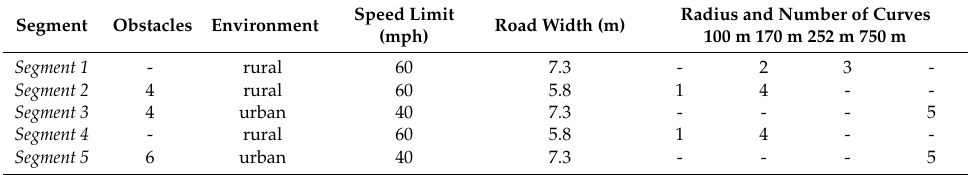
Figure 1. ( a ) Rural environment with roadworks; ( b ) urban environment. Table 1. Road geometry and furniture across different segments (in the order they were experienced).